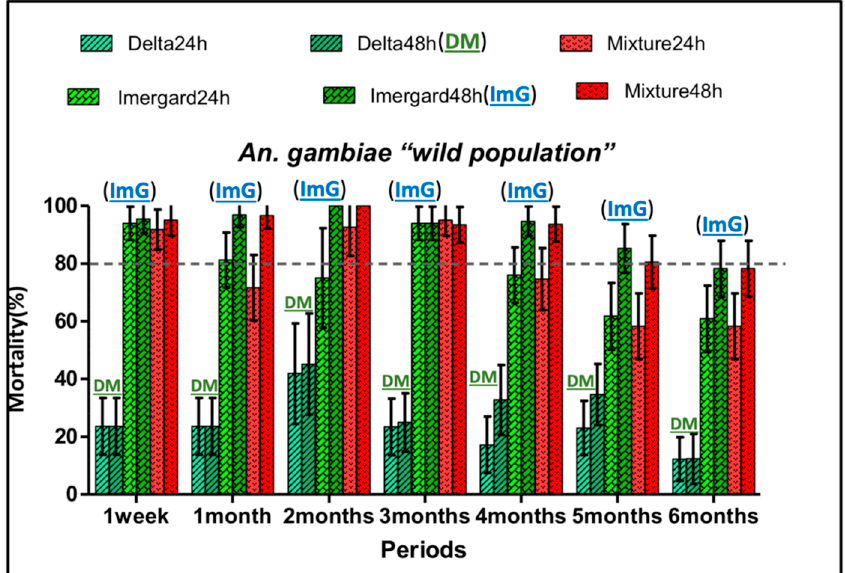
Figure 5. Residual mortality of Imergard TM WP, deltamethrin, and their mixture following cone bioassays with wild resistant Anopheles gambiae (s.l.) in experimental huts in Cove, Benin. For each treatment, mortality was recorded at 24 and 48 h after a 30 min exposure to the walls. Error bars represent 95% confidence intervals. Delta and DM = Deltamethrin; ImG = Imergard TM WP; Mixture = Deltamethrin + Imergard TM WP. The gray dotted line indicates the 80% threshold requirement of the WHO for residual activity.